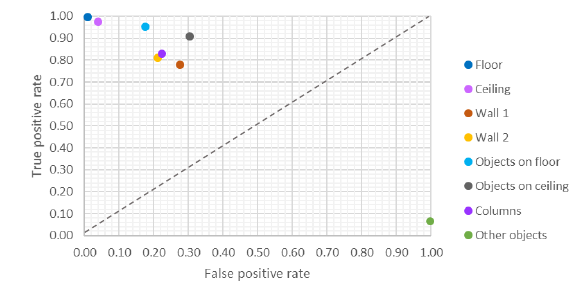
Figure 6 . ROC graph for the car park point cloud.